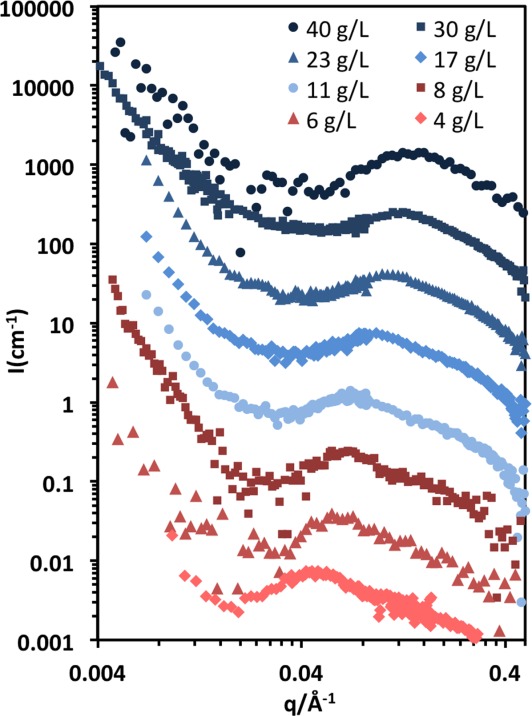
Coherent SANS profiles for aqueous solutions of NaCMC for different concentrations ranging from 4 to 40 g/L, curves shifted in 5× increments for clarity. The 4 g/L curve is not shifted. [Color figure can be viewed in the online issue, which is available at http://wileyonlinelibrary.com.]